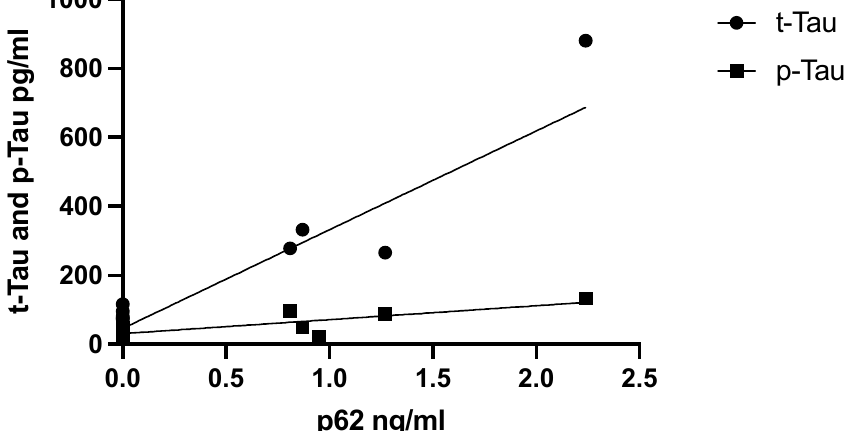
Figure 3. Correlation between CSF p62 and p-Tau and t-Tau concentrations in female FTD patients.